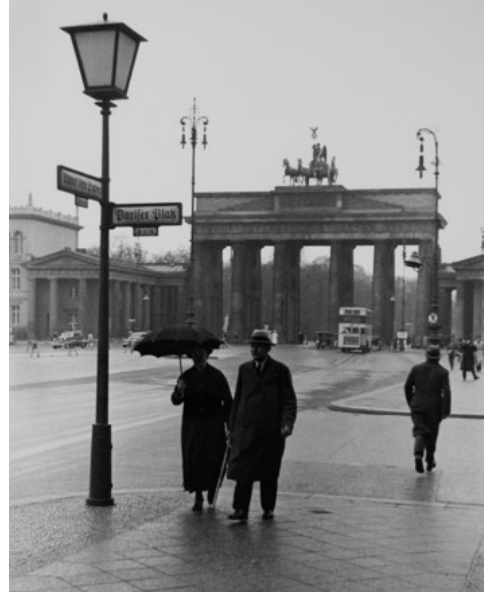
Figure 4. Henry Ries. Brandenburger Tor vom Pariser Platz aus gesehen ( Brandenburg Gate Seen From Pariser Platz ). 1937. Photograph. © Henry Ries. Deutsches Historisches Museum. Invoice No. 2007/4176.176, file PH009544.